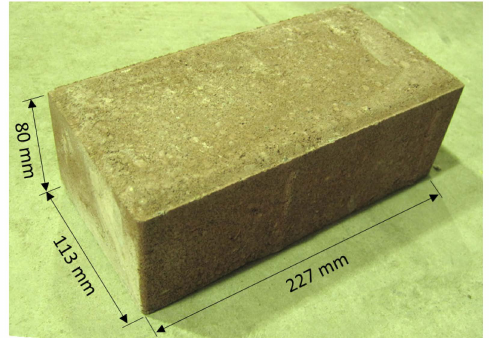
Figure 2. The dimensions of solid concrete